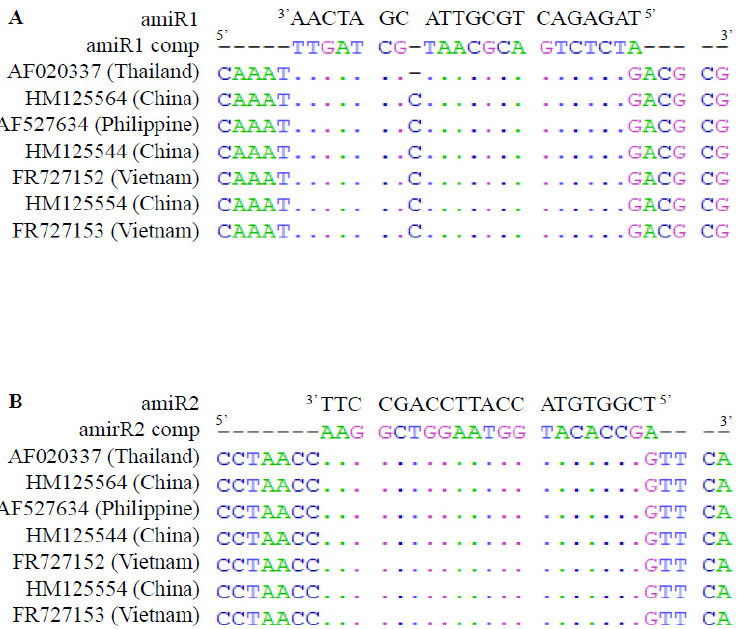
Figure 2. Alignment of amiR1 and amiR2 target sites in RRSV genomes from the GenBank resource. amiR1 ( A ) and amiR2 ( B ) complementary (comp) sequences were aligned to RRSVs6gp1 sequences deposited in GenBank. The accession number and origin of each sequence are indicated. Nucleotide identity and deletions are represented by a dot and a small line, respectively. The sequences of mir1 and mir2 are indicated in black in the 3 ′ –5 ′ orientation.